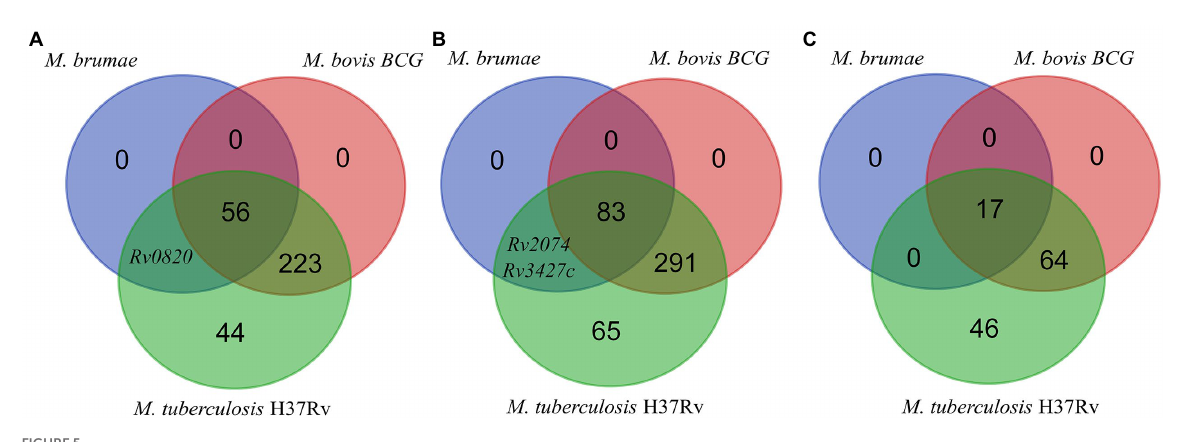
FIGURE 5 Genes presence or absence analysis. Venn diagram showing the comparison of the presence/absence and abundance of M. tuberculosis virulence- associated genes (A) , antigens recognized by T cells (B) , and antigens recognized by B cells (C) in the M. bovis BCG Connaught and M. brumae